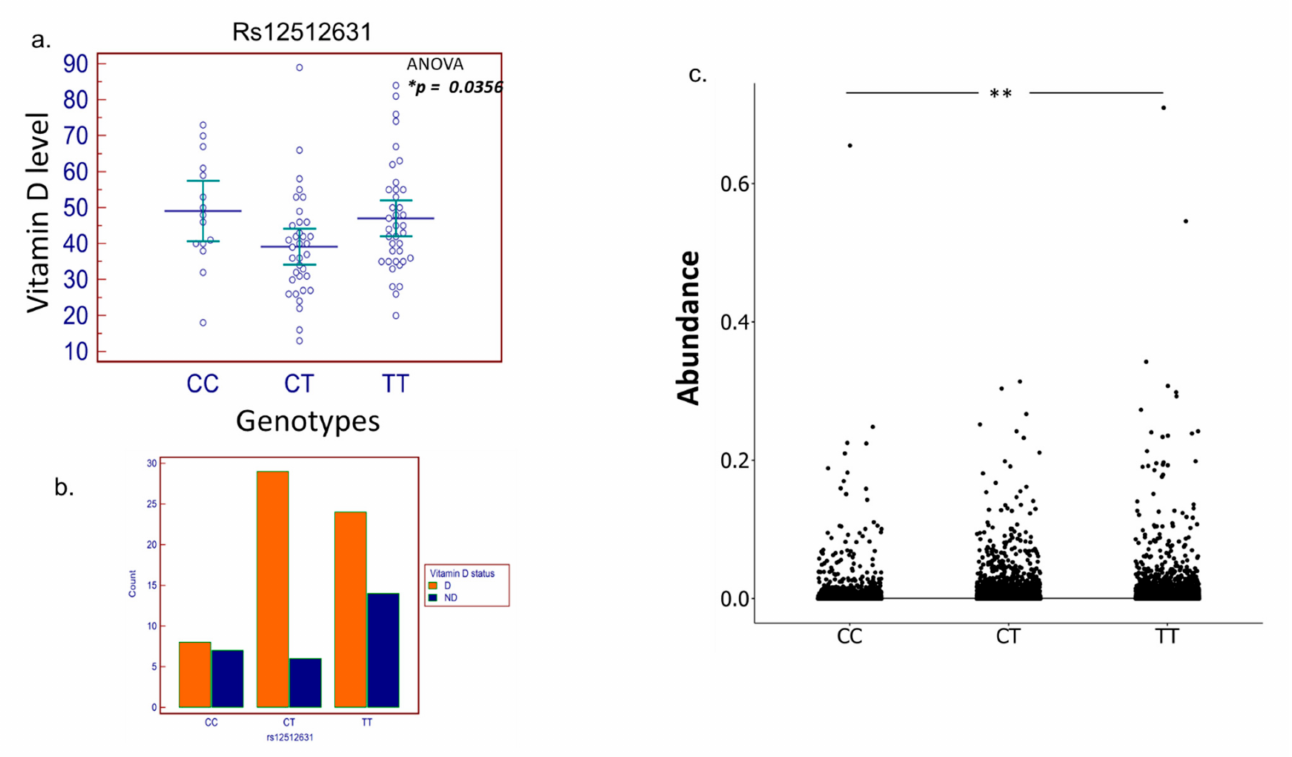
Figure 5. ( a ) The CT genotype (SNP rs12512631 in the GC gene) was associated with low levels of serum vitamin D and ( b ) was highly abundant in the deficient compared to non-deficient subjects (ANOVA * p < 0.05). ( c ) Overall microbial abundance was significantly different between the three genotypes of SNP rs12512631 (Kruskal–Wallis followed by post hoc Dunn’s test with false discovery rate (FDR)–Bonferroni corrected, ** p <